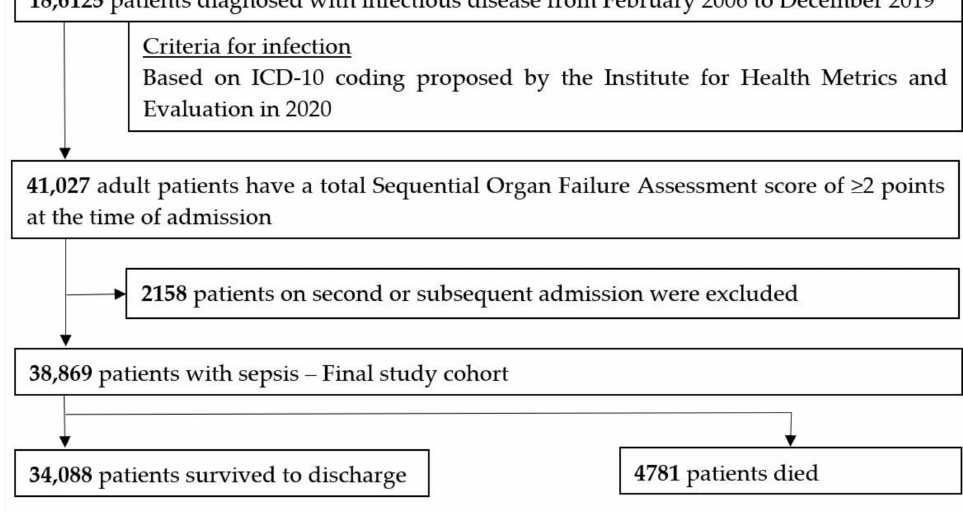
Figure 1. Patient flow diagram. ICD-10: International Classification of Diseases Tenth